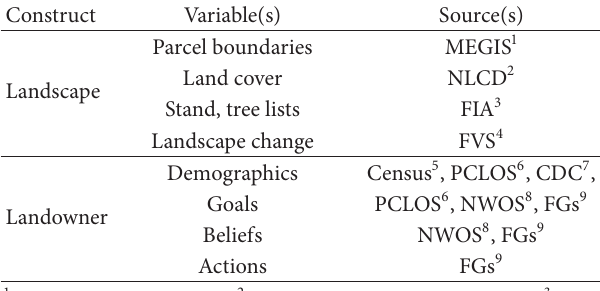
Table 1: The FLAME structure data sources by variables.